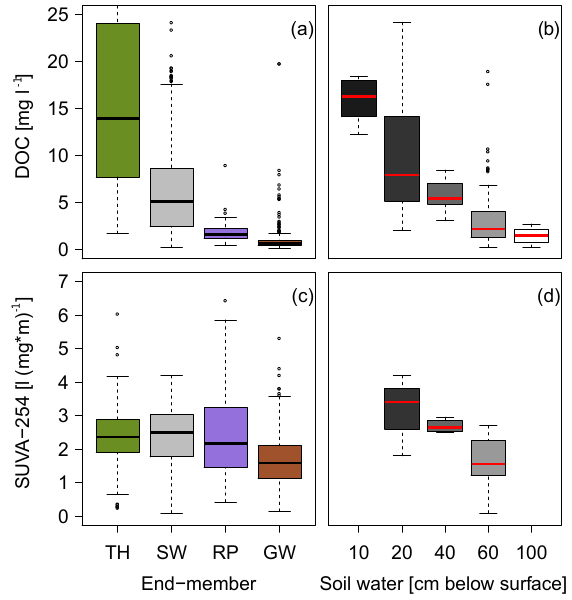
Figure 6. DOC concentrations and SUVA-254 values of the bi- weekly sampled end-members and the detailed information for soil water at different depths. TH is throughfall, SW is soil water, RP is saturated riparian water and GW is